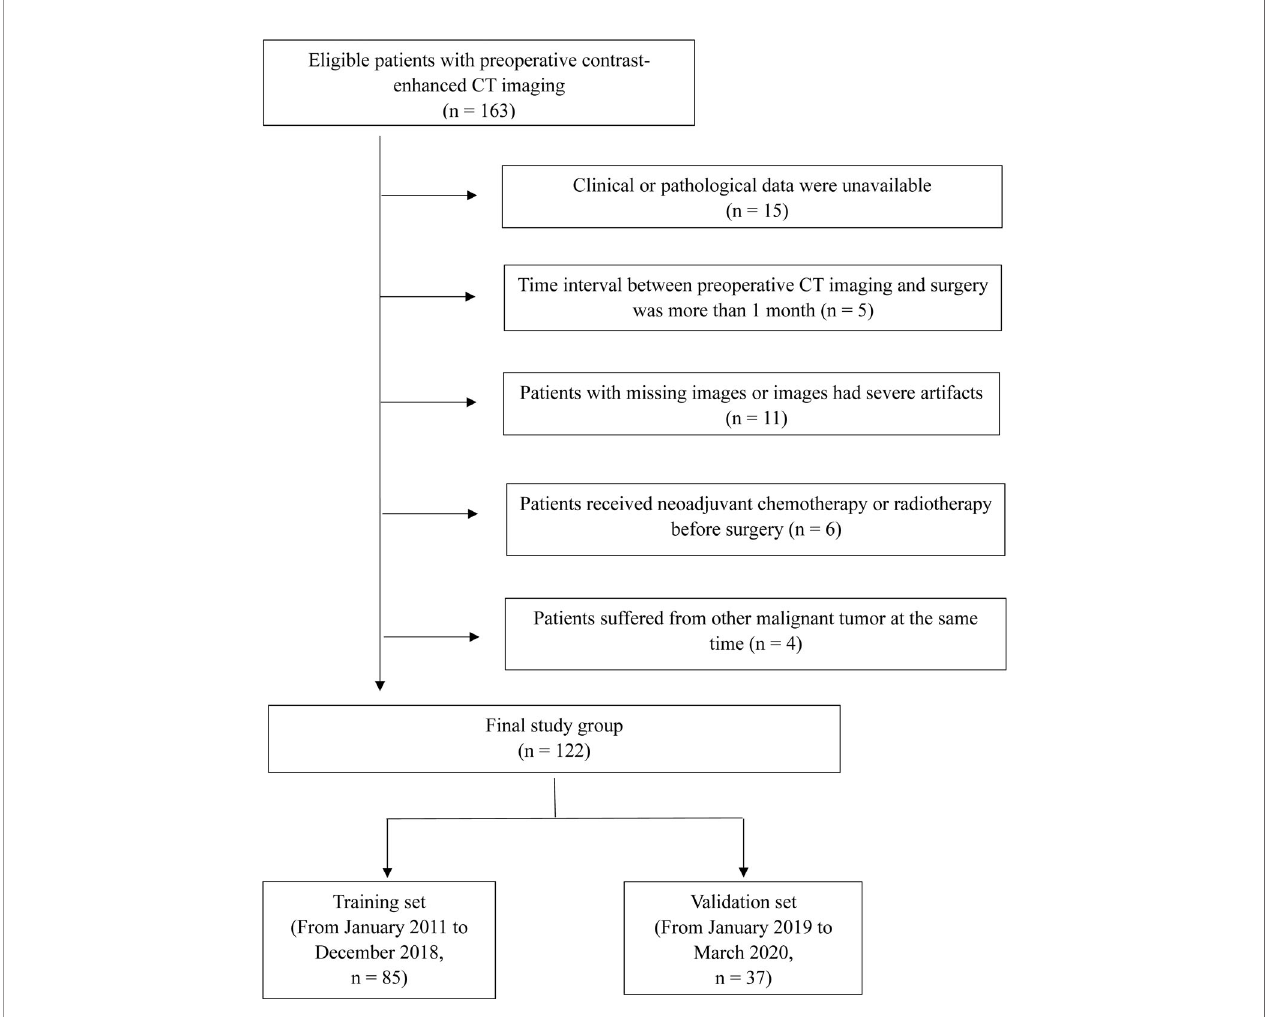
FIGURE 1 | Flow diagram of patient selection